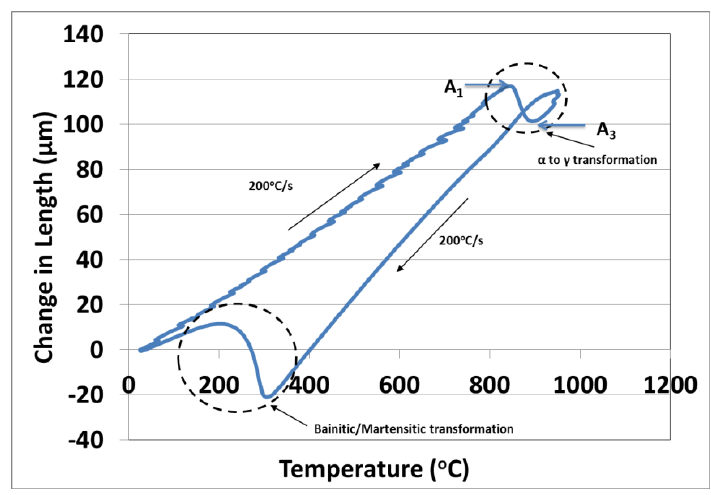
Figure 2. Dilatometry curve of CrMo steel after the UFHT. The change in length at high temperature designates the α to γ transformation. The new A 1 and A 3 temperatures are shifted substantially to 810 °C and 900 °C, respectively.